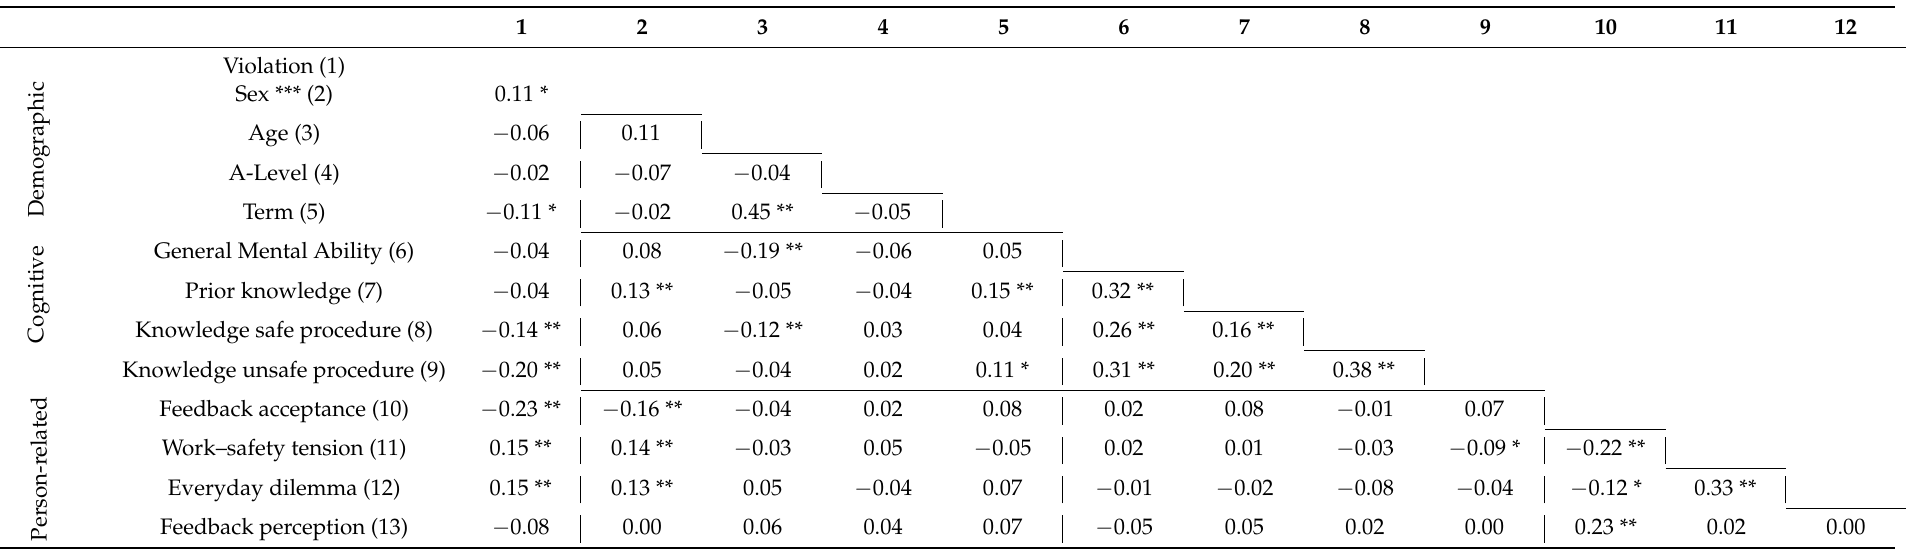
Table 4. Correlation matrix between the control variables and the dependent variable of the rule violation, in demography, cognition, and person-related